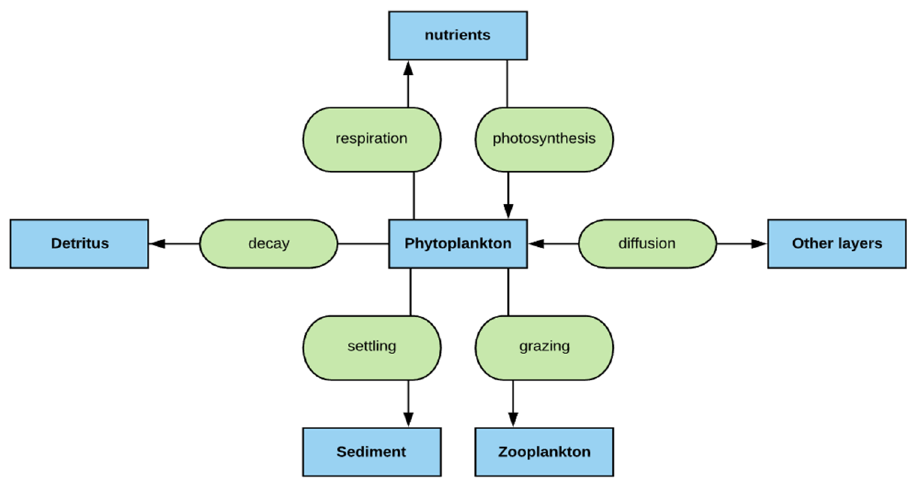
Figure 1. Schematic diagram of phytoplankton (Chlorophyll-a) cycle modeled by MINLAKE2020.